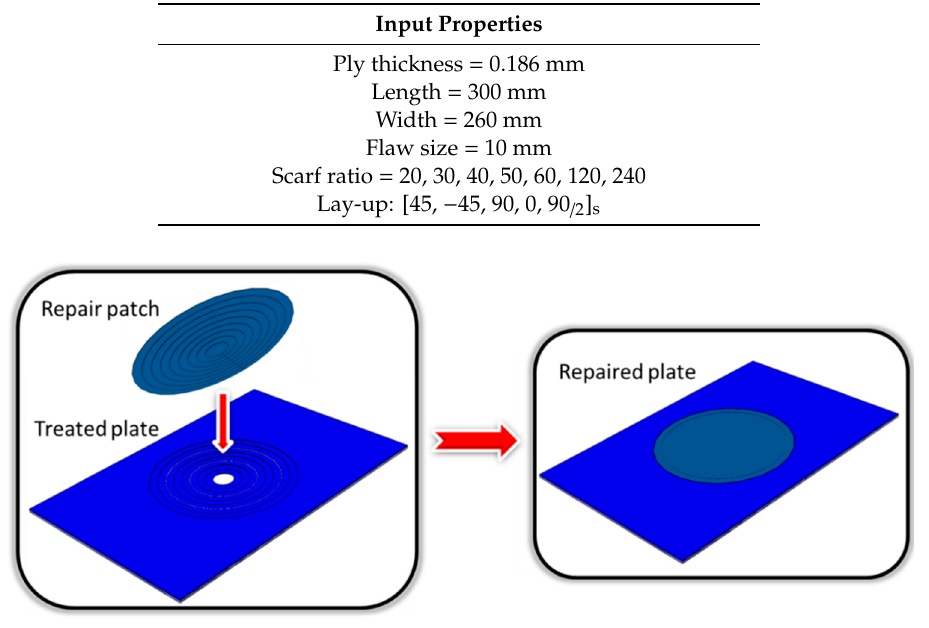
Figure 2. Schematic of patch installation.